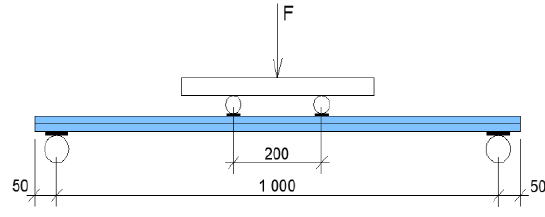
Fig. 2 Static schema of all bending tests.